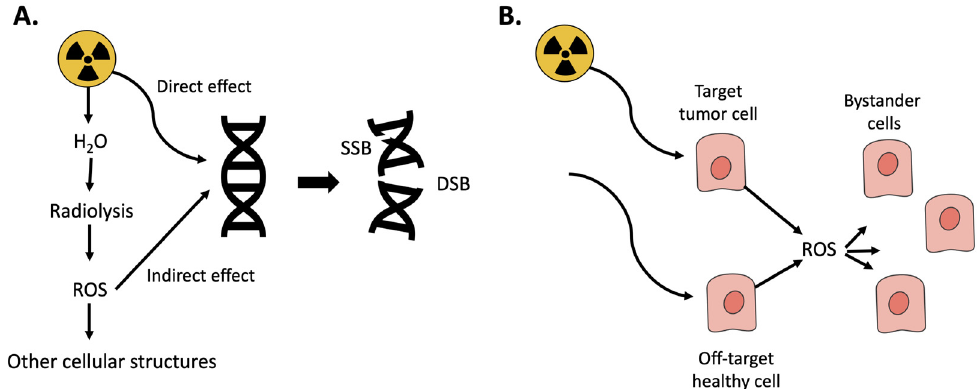
Figure 1. Oxidative stress resulting from ionizing radiation. ( A ) Radiation can have either direct effect resulting in DNA-damage, single or double-strand breaks (SSB/DSB) or react with water in a process called radiolysis resulting in ROS. ( B ) Radiation is used to kill tumor cells; however, it can also damage healthy cells either by directly hitting them or by the resulting ROS.